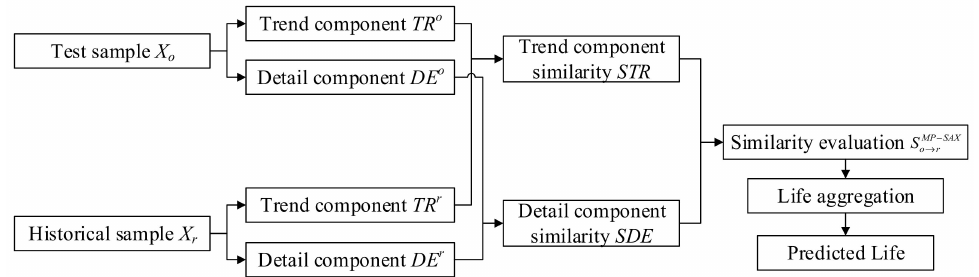
Figure 2. The diagrammatic sketch of the proposed